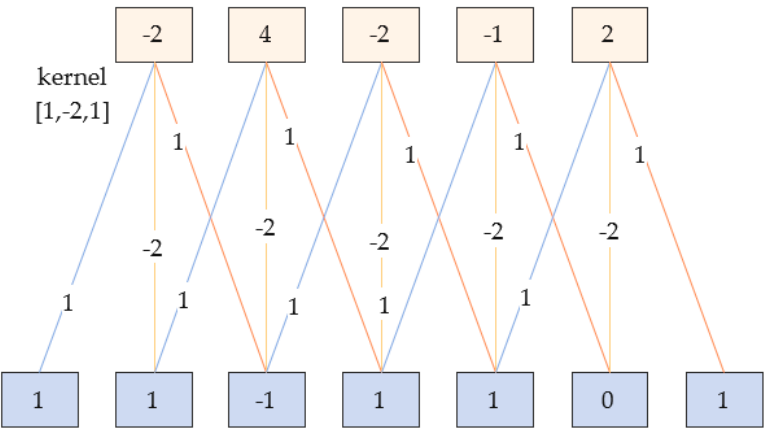
Figure 4. Schematic diagram of the one − dimensional convolution.